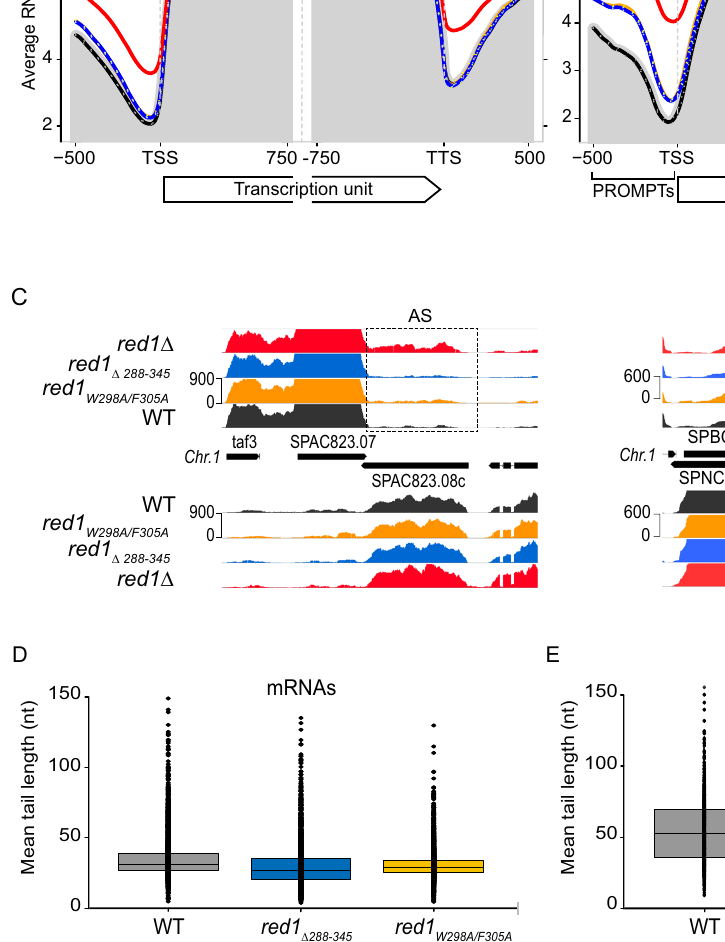
Fig.5|Pla1inthecontextoftheMTRECcomplexisresponsiblefordegradation ofPROMPTs.A , B Metagenepro fi leofsense( A )andantisense( B )RNAlevelsinthe indicatedstrains for a subsetof S. pombe genes with detectablelevelsof PROMPTs (2400 genes). The geometric average of RNA levels from 500bp upstream to 750bp downstream of the transcription start site (TSS) and 750bp upstream to 500bp downstream of the transcription termination site (TTS) are shown. Solid lines represent the average of two replicates for all indicated strains, with the exception of red1 Δ which represent a single dataset. Dotted lines indicate the individualbiologicalreplicates.ThegreyshadingrepresentstheaverageRNAlevels intheWTstrain. C Strand-speci fi cRNA-seqreadcoverageofarepresentativesetof